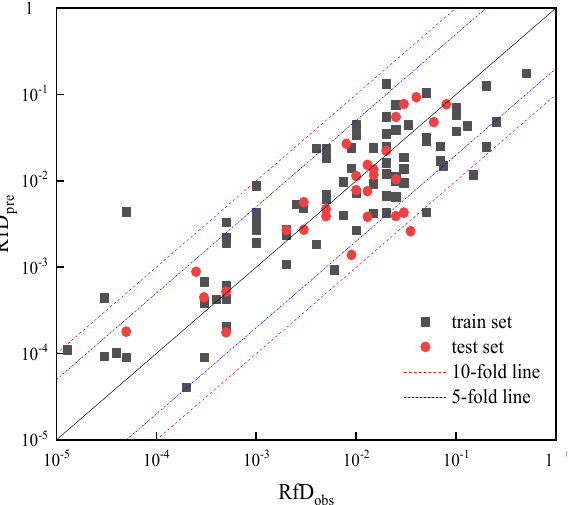
Figure 2. Comparison of observed and MLR-predicted RfD. The squares refer to data in training set and the dots are data in test set. The solid line represents the 1:1 line, while dot-dash lines and short-dashed lines represent a 5-fold and 10-fold difference, respectively, between these values. The predicted RfD values of the two pesticides mentioned are 0.01271 mg · kg − 1 · d − 1 and 0.0002124 mg · kg − 1 · d − 1 , respectively, which are obtained by the above equation with the corresponding molecular parameters. From the biological conception, the RfD values of these pesticides in this manuscript are identi fi ed as 0.01 mg · kg − 1 · d − 1 and 0.0002 mg · kg − 1 · d − 1 .